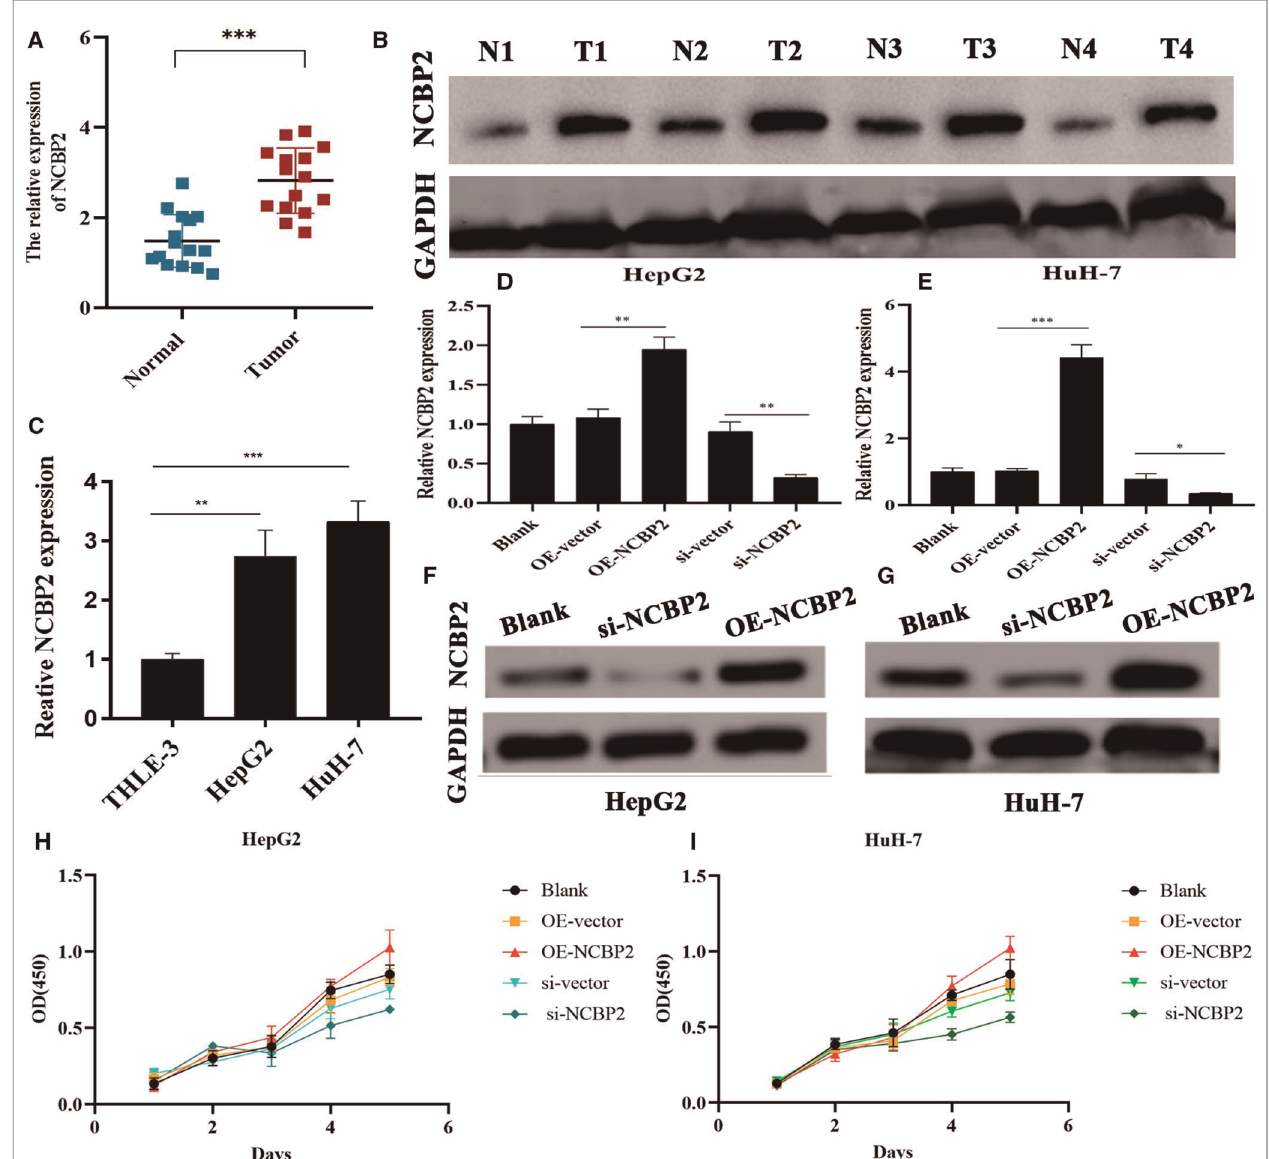
FIGURE 8 | Overexpression of NCBP2 promotes the proliferation of LC cells. ( A ) RT-qPCR detection on 15 pairs of clinical samples con fi rmed the differential mRNA expressions of NCBP2 between adjacent normal and HCC tissues. ( B ) Western blot results for four pairs of clinical samples con fi rming the differential protein expressions of NCBP2. ( C ) Expressive differences of NCBP2 between normal liver and LC cells. ( D,E ) Transfection ef fi ciency of si-NCBP2 and OE-NCBP2 in HepG2 and HuH-7 cells based on RT-qPCR tests. ( F,G ) Effects of si-NCBP2 and OE-NCBP2 on protein expression of NCBP2 in LC cells based on western blot assays. ( H,I ) CCK8 assays exhibited the proliferative abilities of LC cells in different groups. LC, liver cancer; si-NCBP2, small interfering RNA targeting NCBP2; OE, overexpression; * P <0.05, ** P <0.01, *** P